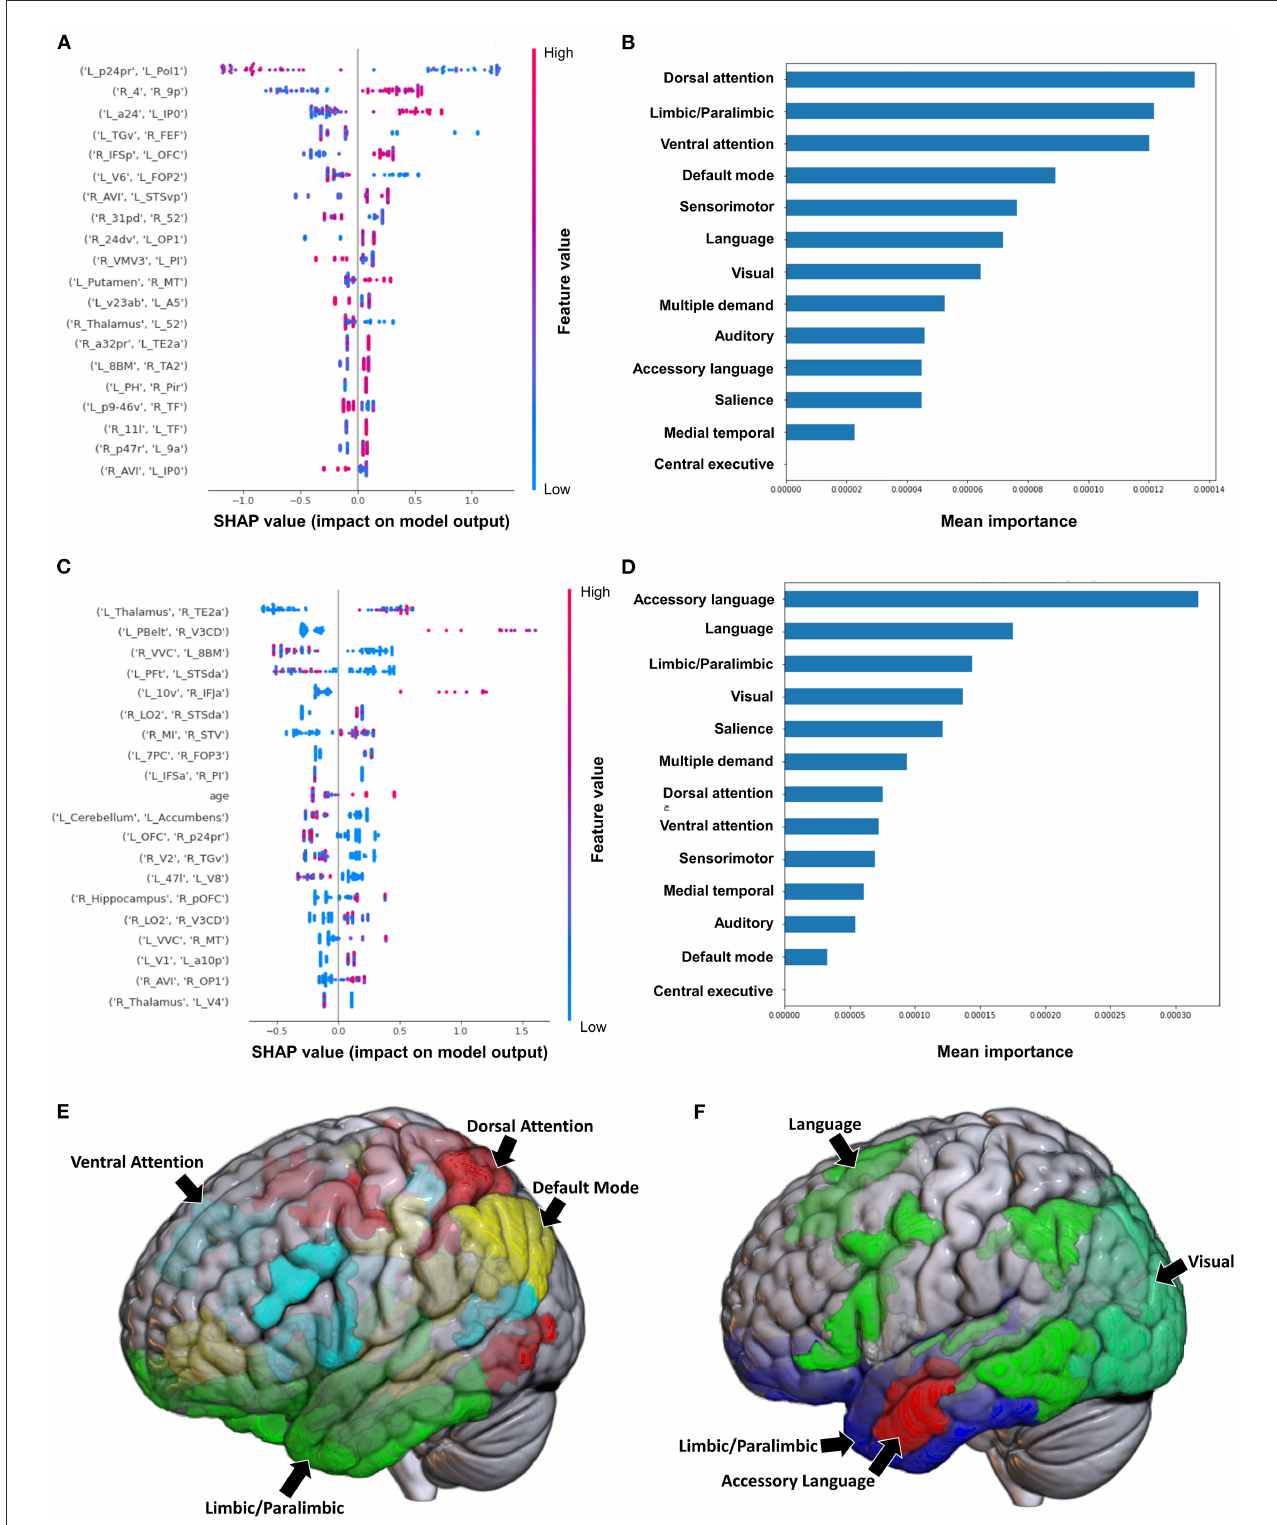
FIGURE1 Feature importance analysis of the models classifying the Brunnstrom stage of recovery—upper extremity based on functional connectivity at the (A) individual brain region level, and (B) the network level; and based on structural connectivity at the (C) the individual brain region level, and (D) the network level. The networks contributing most to the models’ classifications, based on (E) functional connectivity, and (F) structural connectivity, have also been visualized on brain